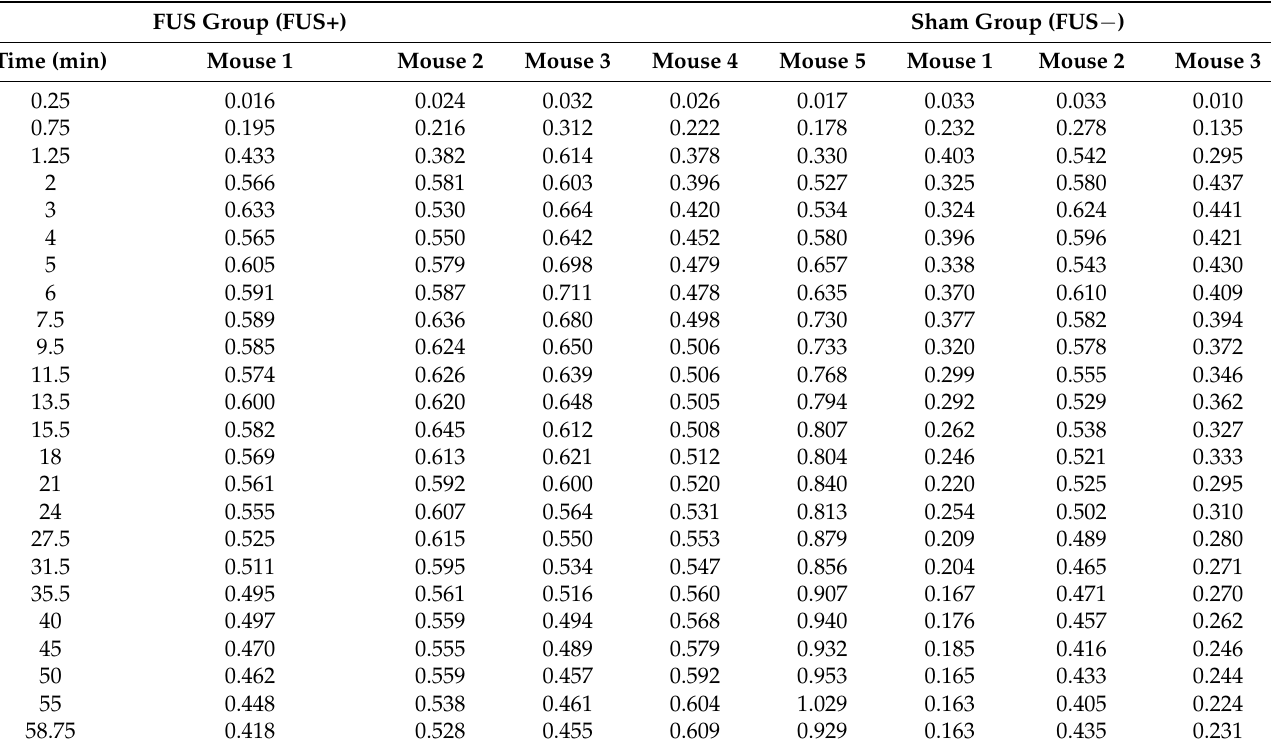
Table A1. SUV values—right hemisphere.